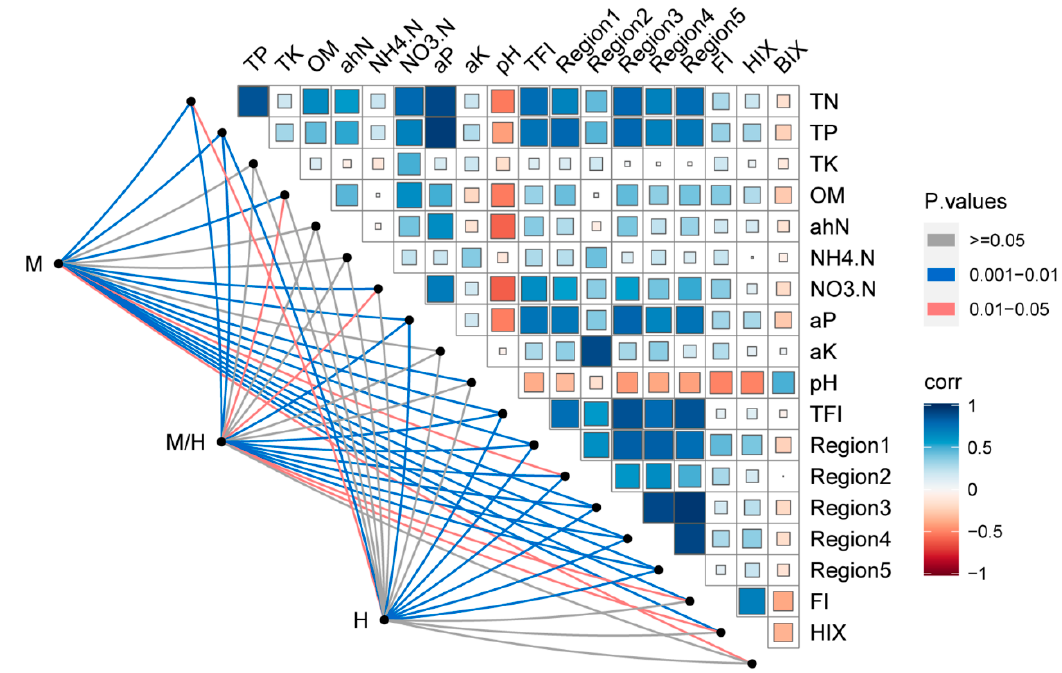
Figure 2. Spearman’s correlations between environmental factors and soil dissolved organic matter (DOM) properties, and the results of Adonis analysis of management (M), hedgerow (H), and their interaction (M / H). Edge color denotes the statistical significance based on 999 permutations.